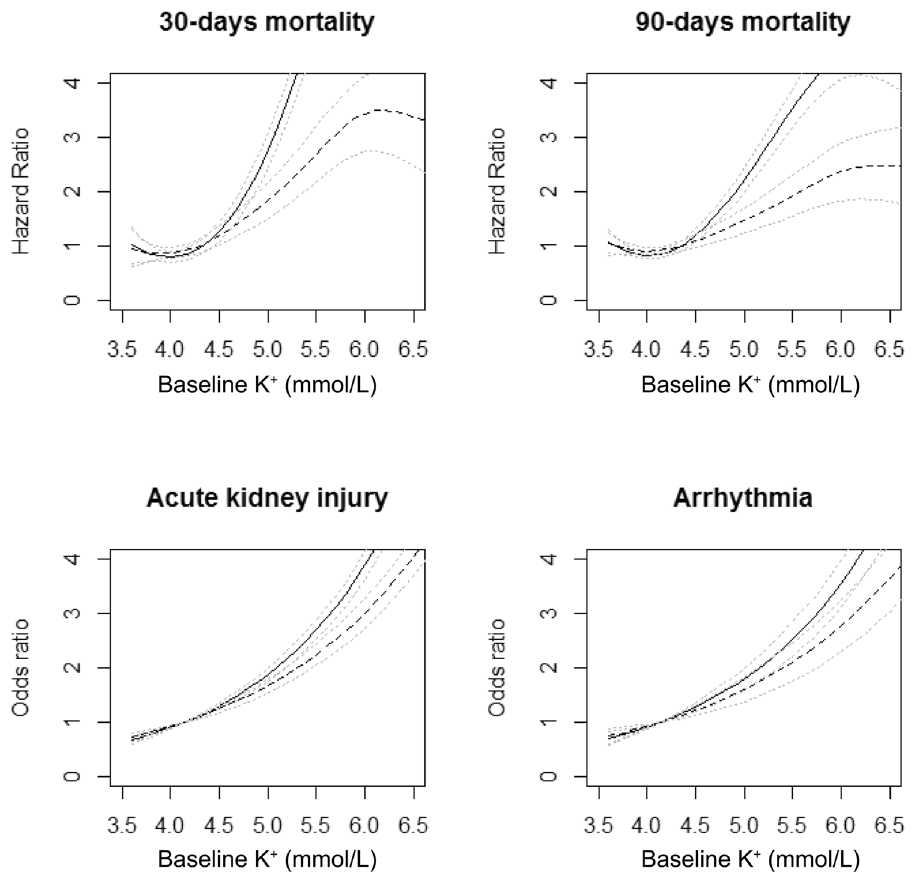
Figure 4. Penalized smoothing splines showing the relationship between baseline serum K + levels and risks for each adverse outcome. The black, linear lines indicate the results of univariable analyses, and the black, broken lines indicate the results of multivariable analyses. The grey, dotted lines indicate the associated 95% confidence intervals. The multivariable analyses are adjusted for the following variables; age, sex, history of cancer, ischaemic heart disease, heart failure, hypertension, diabetes mellitus, baseline estimated GFR and total CO 2 , presence of hypoalbuminaemia (albumin level less than 3.5 g/dL), anaemia (haemoglobin level less than 11 g/ dL), and baseline use of ACE I/ARBs, beta blockers, diuretics and NSAIDs. Baseline estimated GFR and total CO 2 were included in the analysis as continuous variables (natural unit), as the laboratory findings were directly related to levels of serum K +